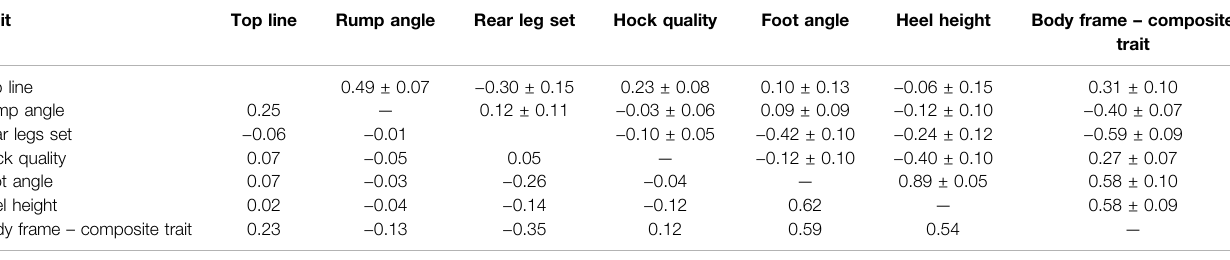
TABLE 7| Estimated genetic correlations ± standard errors (above diagonal) and phenotypic correlations (bellow diagonal) for scored and composite body frametraitsfrom Group 5. Trait